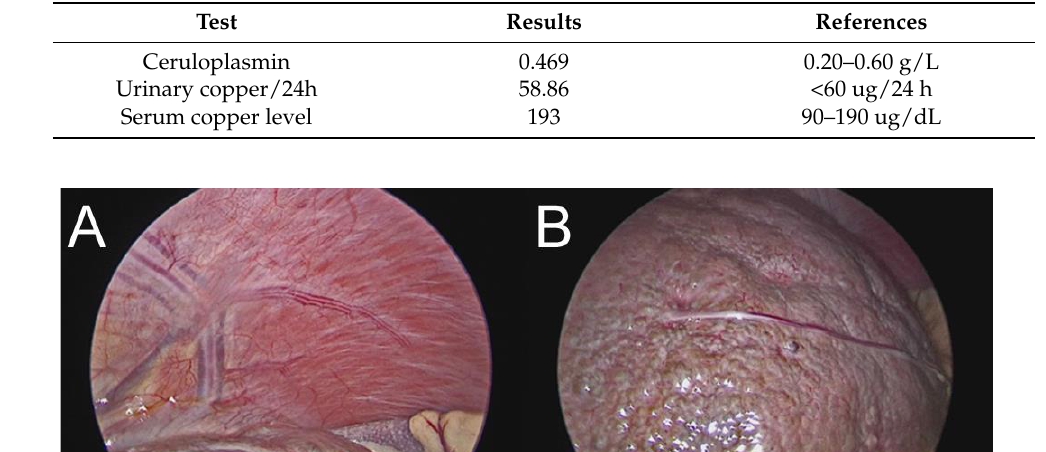
Table 1. Copper metabolism test results.